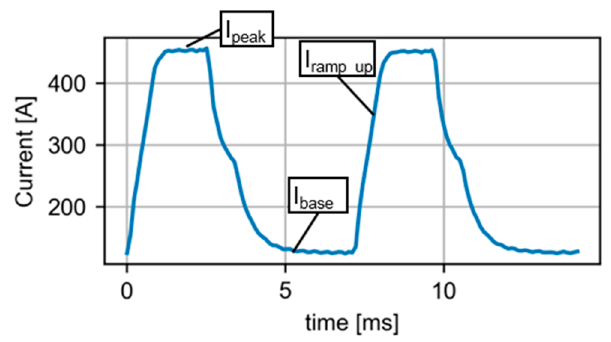
Figure 3. Current wave during drop formation on Gas Metal Arc Welding (GMAW).